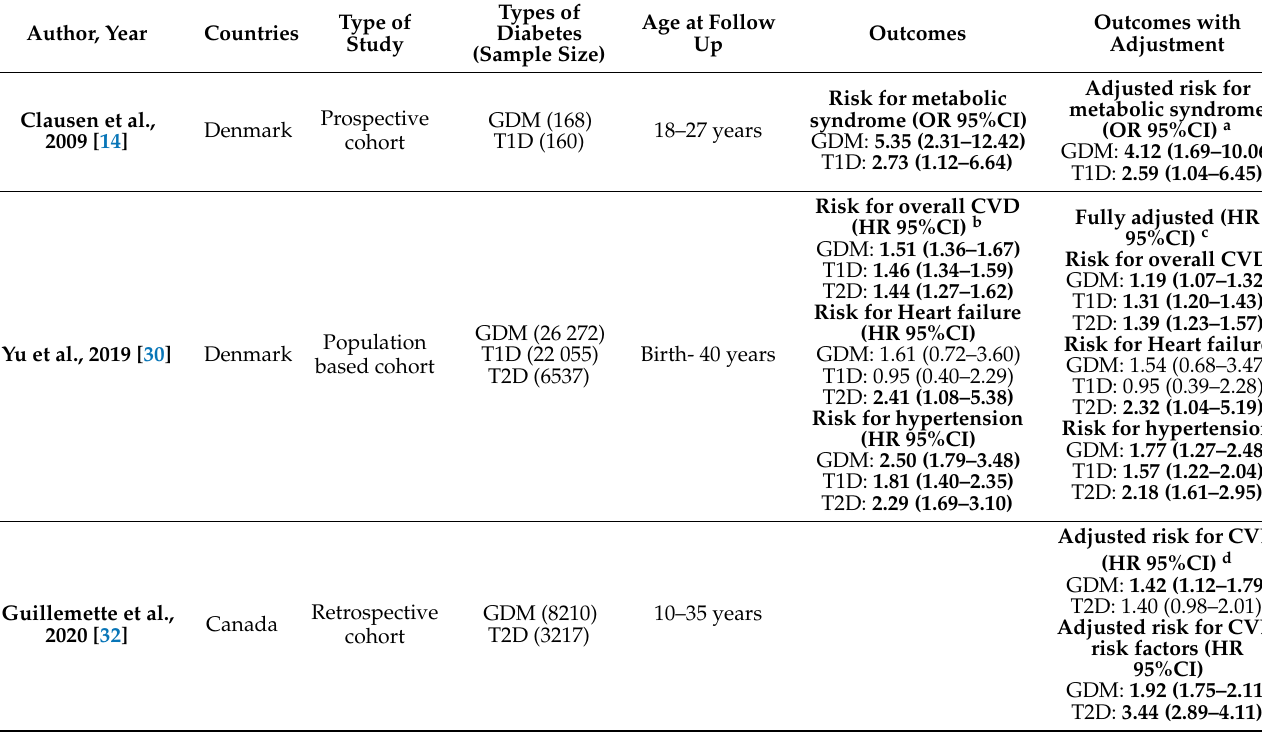
Table 4. Risk for cardiovascular disease and metabolic syndrome in offspring according to the type of diabetes during